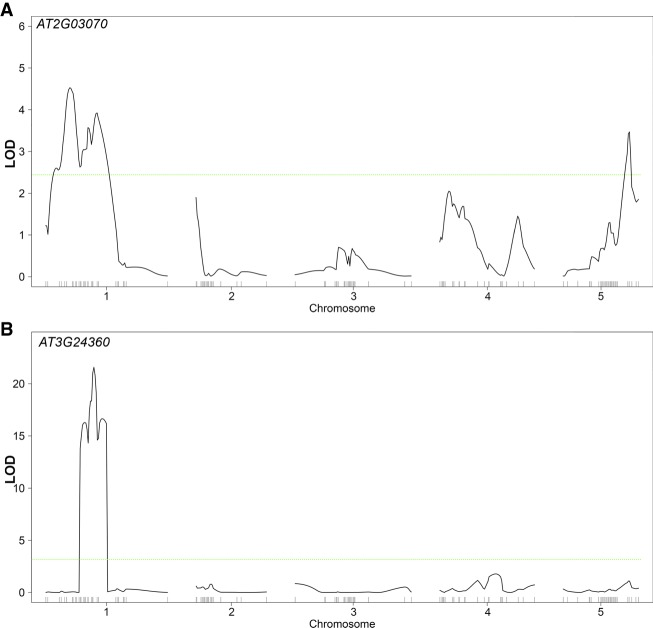
Expression QTL analysis in epiRILs. (A) AT2G03070 and (B) AT3G24360. RNA was extracted for 93 epiRILs, reverse-transcribed to cDNA, and quantified by SYBR Green qPCR. Gene expression was normalized against the reference gene TIP41 and subjected to eQTLepi analyses. Green line indicates LOD significance threshold that was calculated using 1000 random permutations with α 0.05 as the genome-wide type 1 error level. Markers positions are indicated on the bottom of the graph.